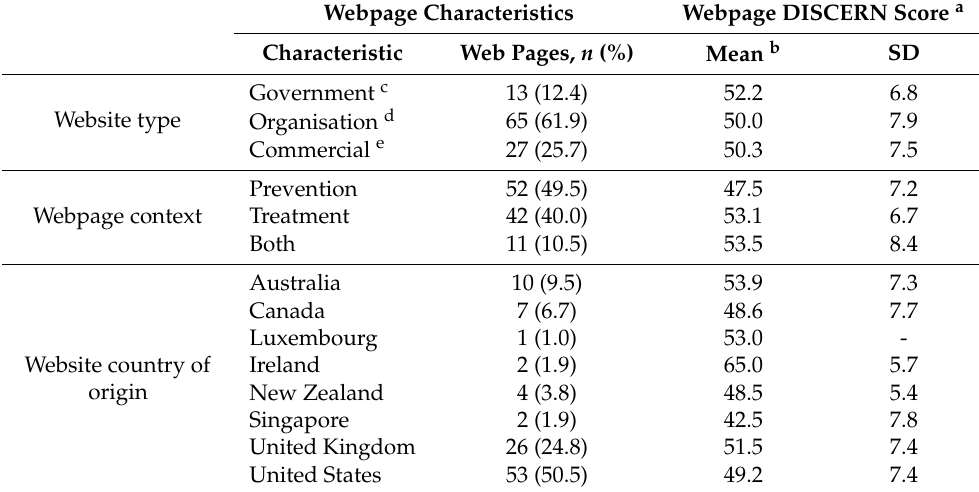
Table 1. Webpage characteristics and webpage DISCERN scores (N = 105).